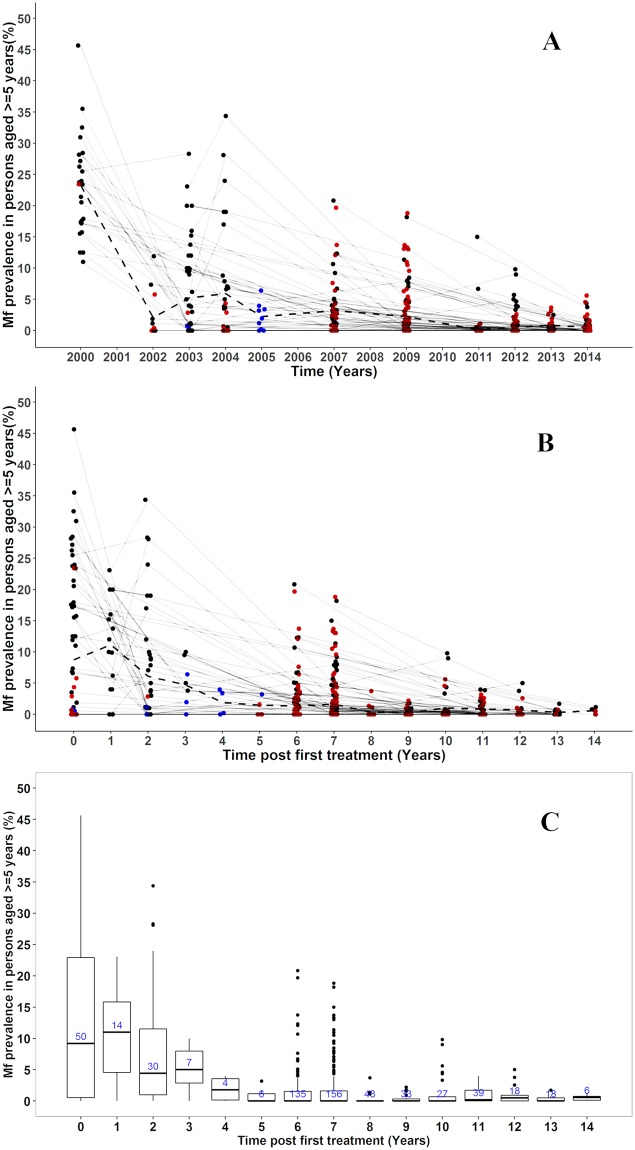
Observed lymphatic filariasis mf prevalence in sentinel and spot-check sites in Ghana, measured in the population aged 5 and above, for the period 2000–2014.A) Data presented by calendar year. Multiple observations from the same community are connected through thin grey lines. Observations from communities surveyed only once are highlighted in brown. Observations presenting aggregated prevalence over multiple communities are displayed in blue (in 2003 and 2005). Dashed lines represent the average prevalence from all surveyed communities at each time point. Bullets at the same time point have been jittered to avoid overlapping of points at the same position; these do not represent time in months. B) As panel A but with time since first treatment on the horizontal axis. C) As B, but with data summarized in boxplots. The box at each time post treatment represents the interquartile range of mf prevalence in ≥5 years and the thick horizontal lines across each box represent the median mf prevalence. The bullets outside each box (above or below) represent the outliers and are defined as 1.5 times the interquartile range above or below the ends of the box (25th and 75th percentile). The vertical lines (whiskers) extend to the first value (mf prevalence) before the outlier cut-off and where there are no outliers, they represent the minimum and maximum mf prevalence at each time post treatment. The numbers in the boxes are the total number of communities examined at each time post treatment.